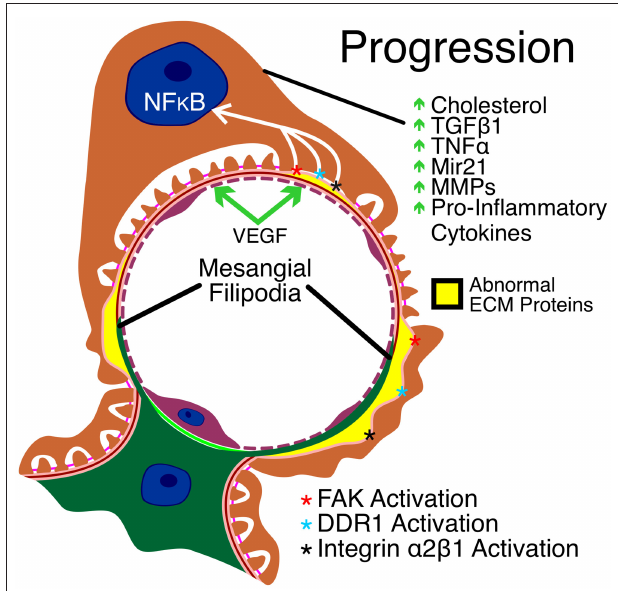
FIGURE 2 | Key aspects of Alport glomerular disease progression. As a result of CDC42 activation, mesangial filopodia invade the space between the endothelial cells and the GBM. The abnormal ECM accumulates in the apical aspects of the GBM, contributing to the irregular thickening of the GBM (in yellow) and activating yet unknown laminin α 2 receptors resulting in FAK activation and downstream NF-kappaB activation. In addition, collagen α 1(III) in the GBM activates DDR1 and α 2 β 1 receptors on podocytes leading to further podocyte injury. The resulting injury to podocytes in mediated by cholesterol retention and elevated expression of TGF- β 1, TNF- α , mir21, MMPs and several pro-inflammatory cytokines. Endothelial cell injury is mediated by elevated